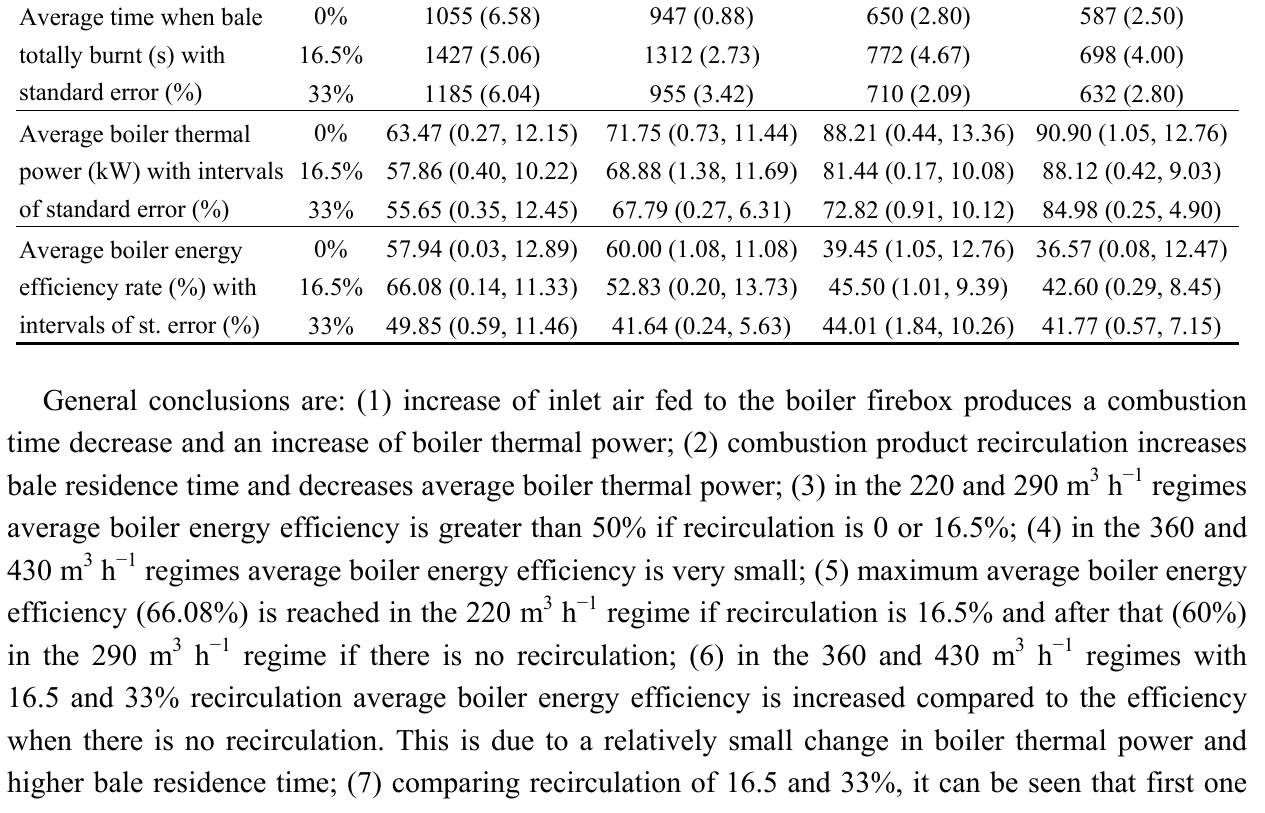
Table 3. Combustion process results with intervals of standard error in percentages.